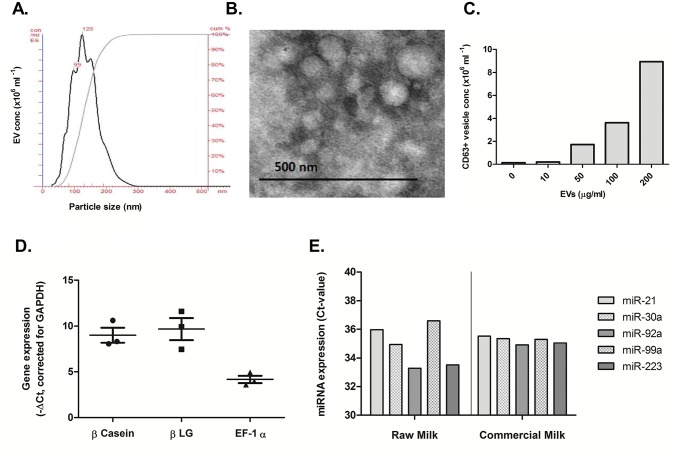
Characterization of bovine milk-derived extracellular vesicles.(A) Size distribution of isolated EVs observed in a NanoSight LM12. Raw data was analyzed with NTA software, with a minimum expected particle size of 50nm. At least 200 tracks had to be analyzed per sample for inclusion in final analysis. Data presented is a representation of >15 samples in multiple experiments. (B) Electron microscopy of the ultracentrifugation pellet from milk showed both exosomes with spherical shapes (30–100nm) and larger EVs ranging from 100–200nm. (C) Exosome capture assay, exosomes were captured with an anti-CD63 antibody, prior to elution and validation by NTA. (D) Detection of bovine specific RNA in EVs. β -Casein, β-Lactoglobulin (β LG) and elongation factor-1α (EF1α) were detected by RT-qPCR in both colostrum and commercial milk. (E) Detection of immunoregulatory miRNAs in EVs, including miR-21, miR-30a, miR-92a, miR-99a and miR-223.